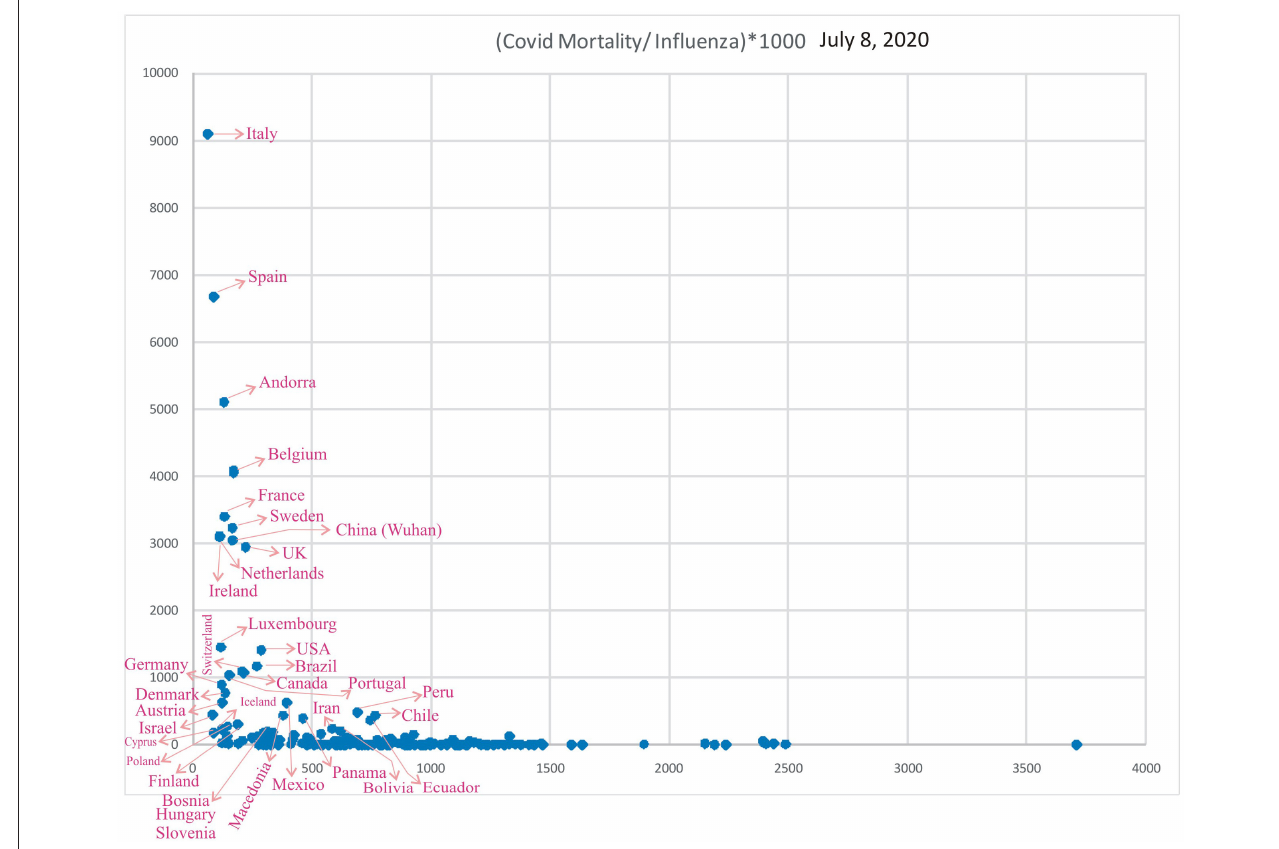
FIGURE 12 | Correlation of Influenza LRI’s/100,000 (x) vs. Variable (y), COVID-19 Mortality/Influenza LRI, July 8, 2020 ( n = 182).